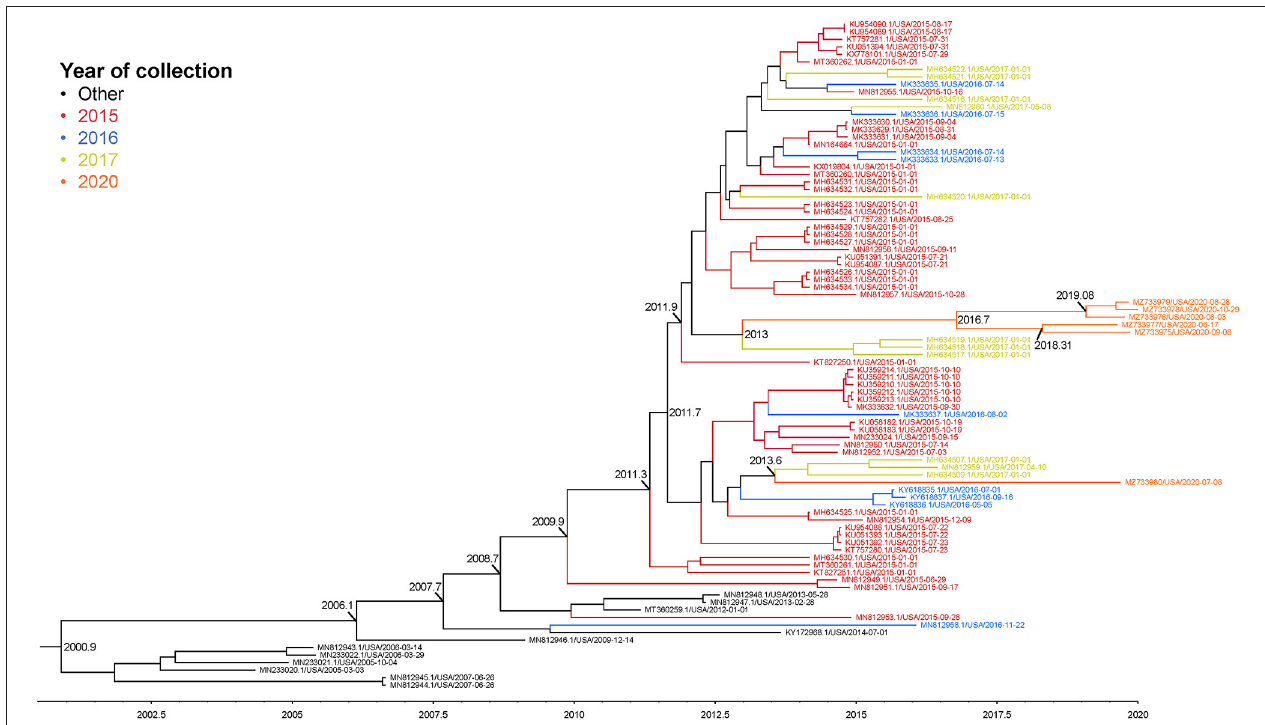
FIGURE 3 | Maximum clade credibility (MCC) phylogenetic tree representing the evolutionary history of 83 SVA genome sequences and the six 2020 isolates. Colors indicate year of sample collection date. The x-axis indicates a timescale in years. Nodes are labeled with years of an estimated common